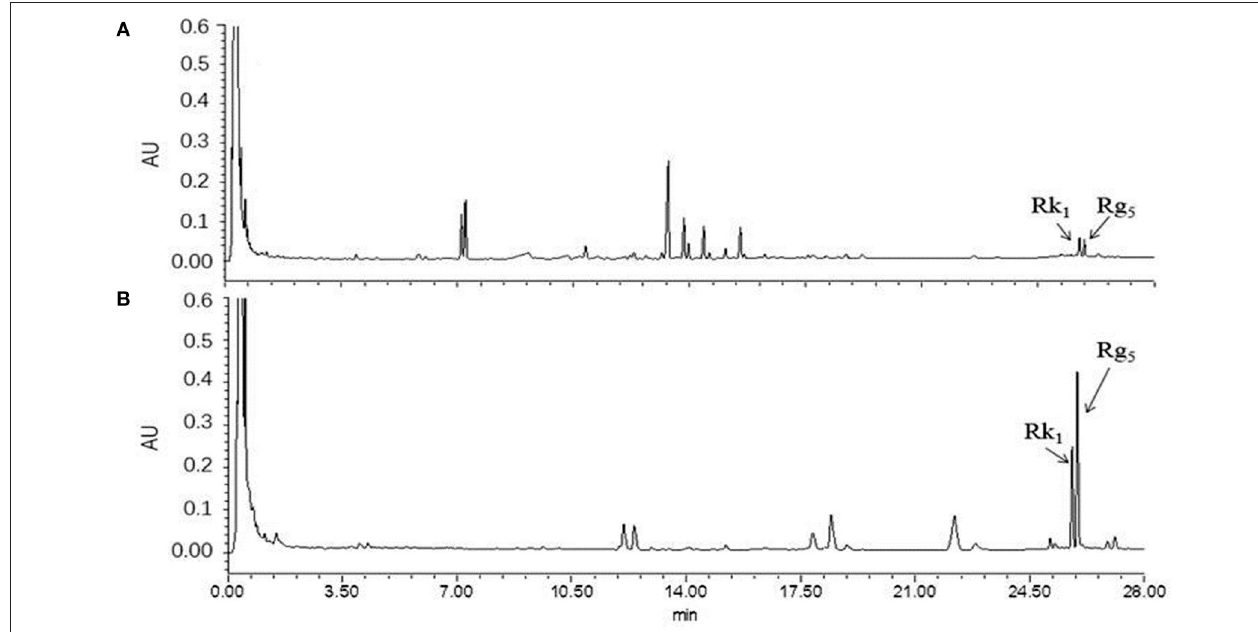
FIGURE 3 | UPLC diagram before and after the reaction of American ginseng. (A) before reaction, (B) after reaction ( n = 3).